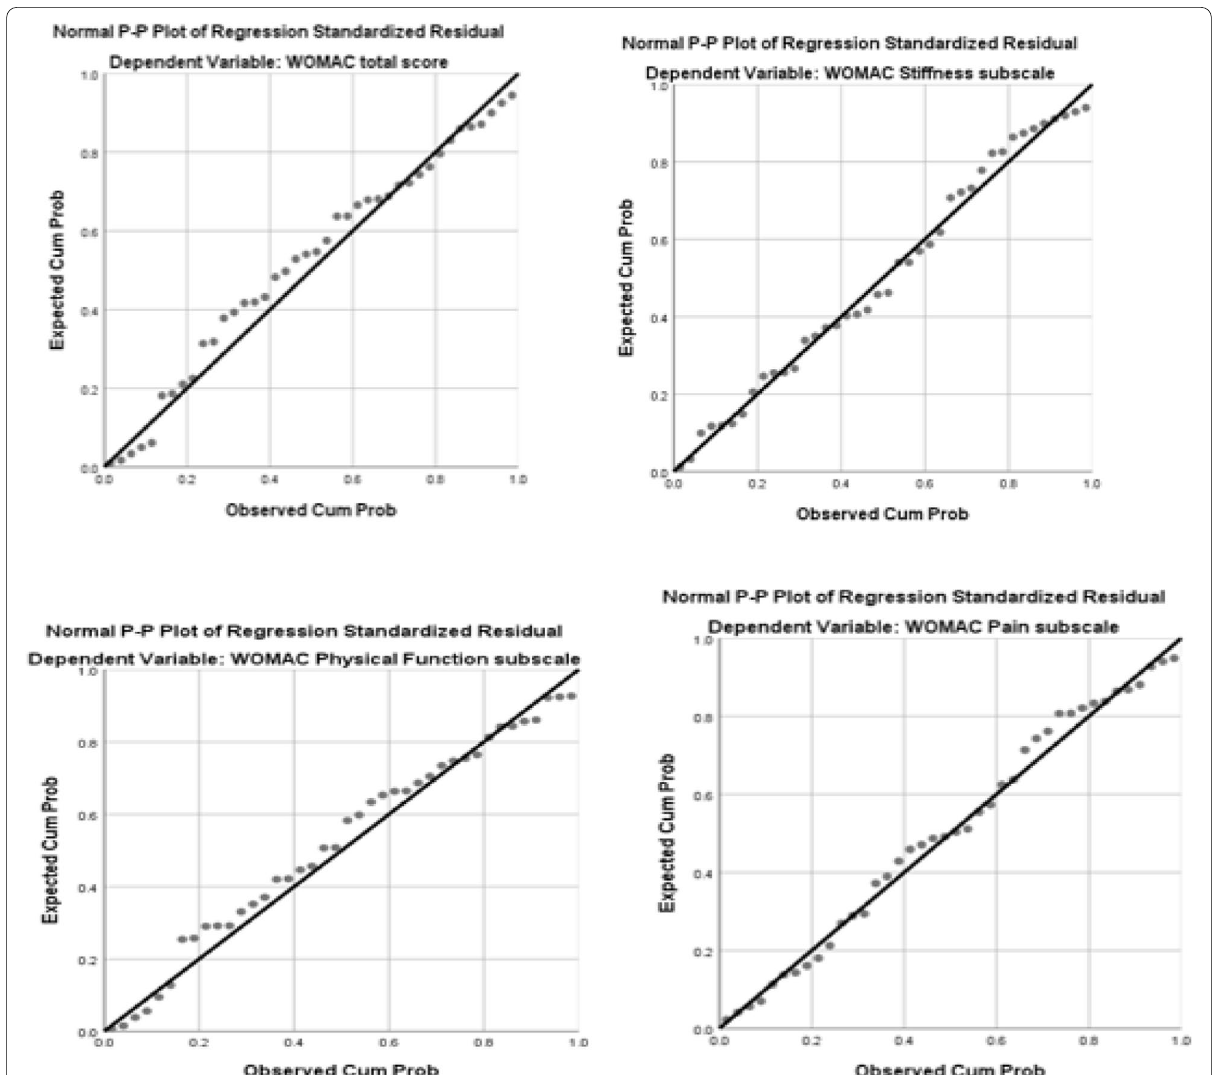
Fig. 3 Multivariate linear regression analysis for the parameters affecting WOMAC total score and WOMAC